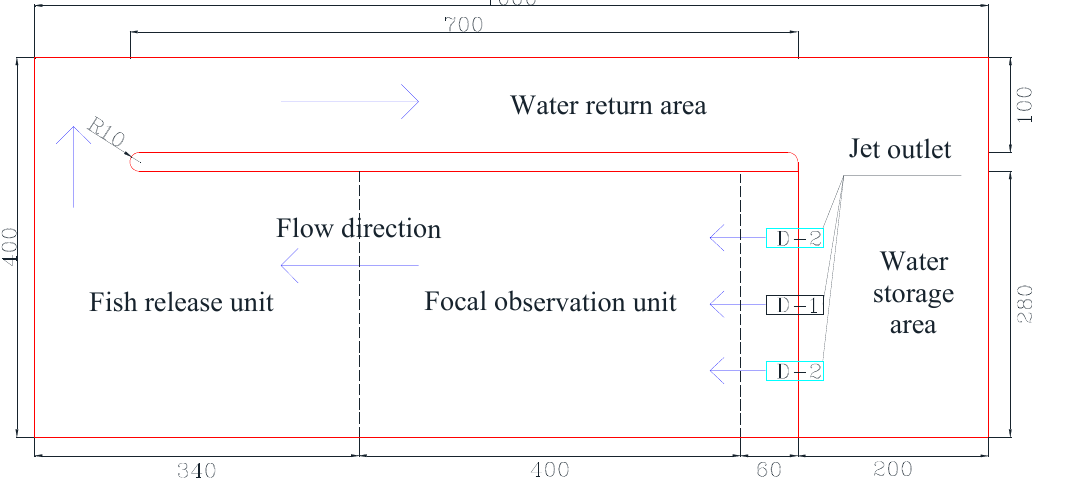
Figure 1. Test model generalization diagram (unit: cm) (D ‐ 1—it represents the flow conditions of single ‐ peak outflow; D ‐ 2—it represents the flow conditions of bimodal outflow). The red line is the boundary line of the model (actually exists), and the black dotted line is the schematic line of the division of the internal area of the model (not really exists).